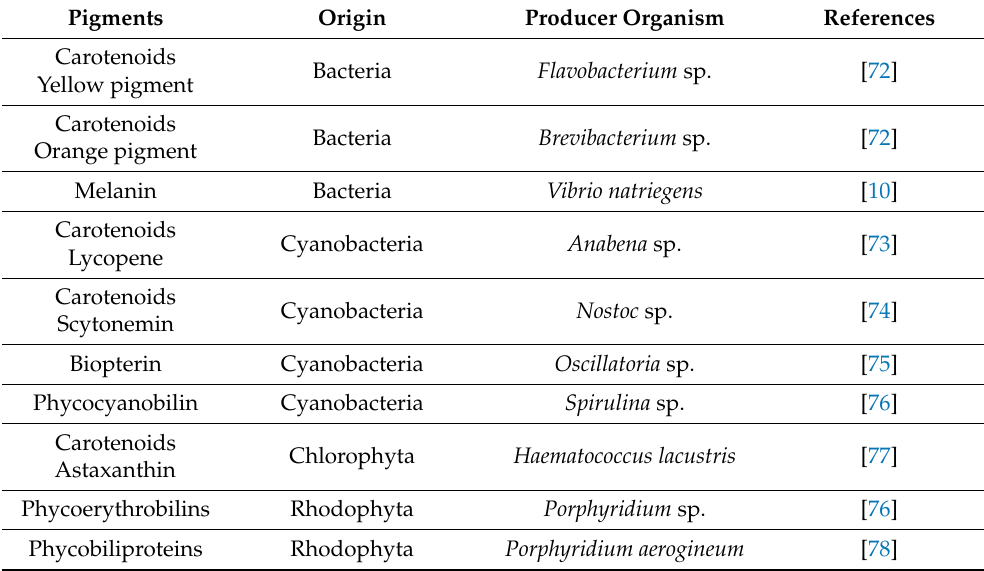
Table 1. Some studies focused on the photoprotection activity of different microbial pigments.